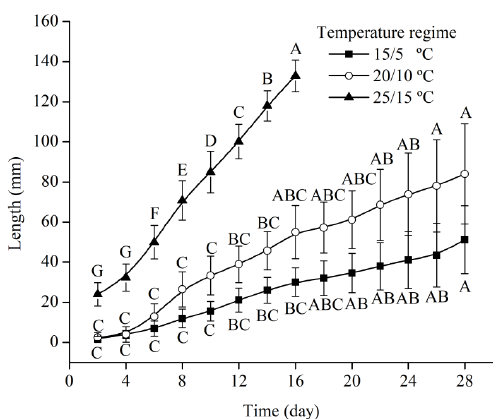
Figure 4. Length of elongated cotyledonary petiole and root of Quercus chungii under three temperature regimes. Different uppercase letters indicate significant differences between the different time points under the same incubation temperature regime (Tukey’s HSD test, p = 0.05 ).